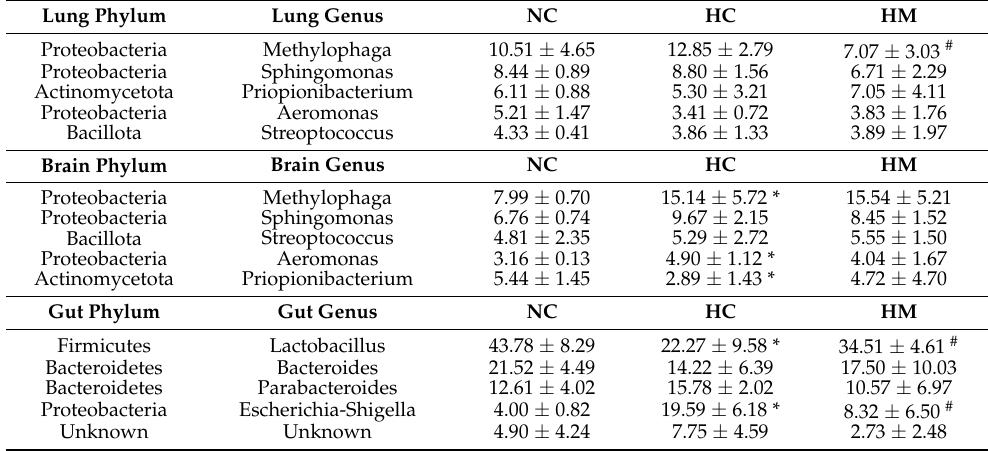
Table 2. Relative abundance of genus.